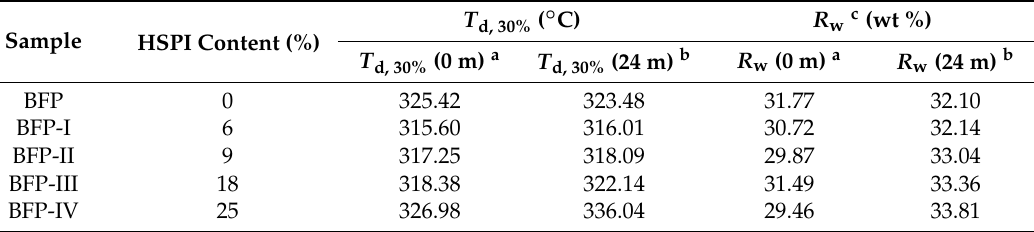
Figure 6. TGA curves of before ( a ) and after ( b ) degradation of BFP, BFP-I, BFP-II, BFP-III, and BFP-IV composites. Table 1. Effect of HSPI content of HSPI/U/F copolymer resin on the thermal property of BFPs composites.